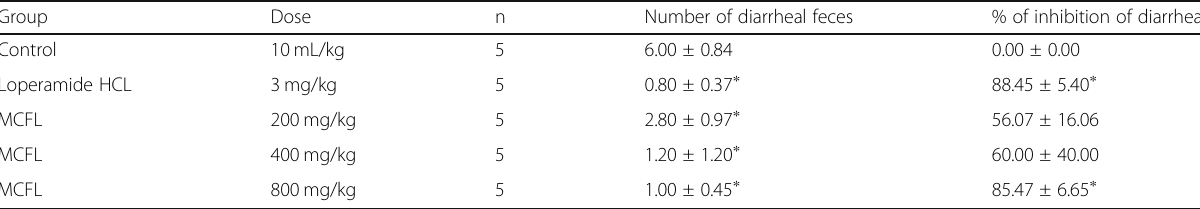
Table 1 Effect of MCFL in castor oil-induced diarrheal test Group